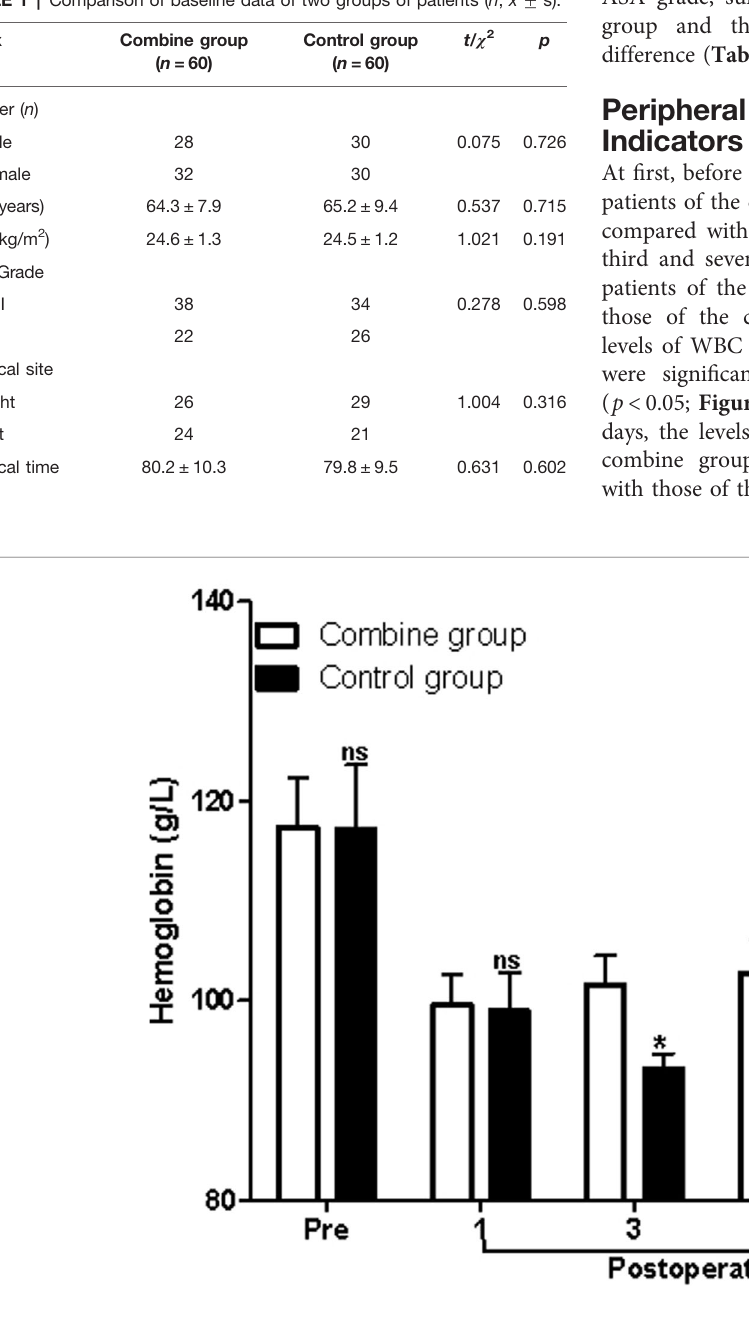
TABLE 1 | Comparison of baseline data of two groups of patients ( n , (cid:1) x + s).